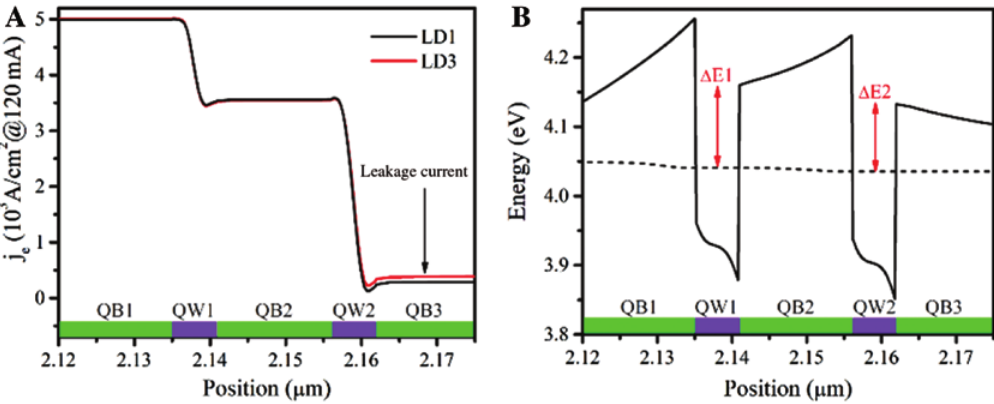
Figure 7: The optical field is moved towards the p-side slightly when using a u-In threshold current of LD1 and LD3 is 27.1 mA, and 36.6 mA, respectively, and the output optical power of LD1 and LD3 is 115.6 mW and 72.1 mW, respectively, at the same injection current of 120